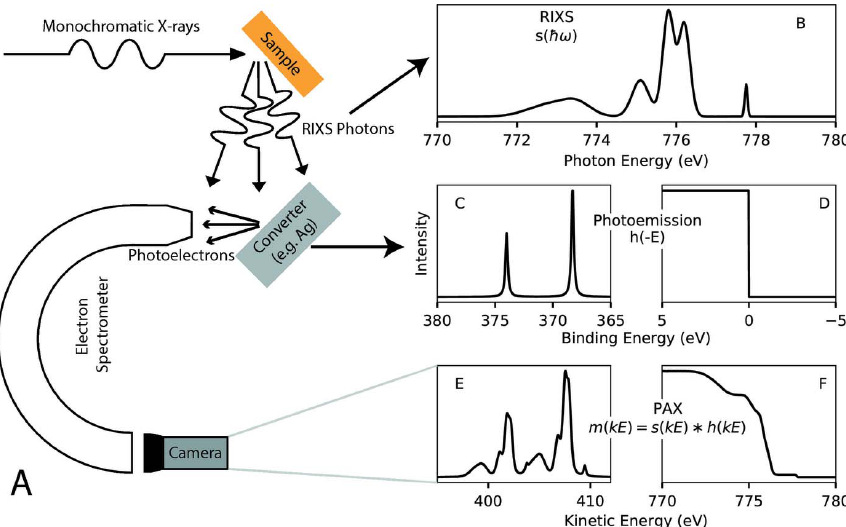
Figure 1 Concept of PAX for estimating RIXS spectra. (A) Experimental schematic. Monochromatic X-rays are incident on a sample which emits RIXS photons. These photons are directed onto a converter material resulting in photoemission. The energy distribution of these photoelectrons is detected with an electron spectrometer giving a PAX spectrum. We estimate the RIXS spectrum from the measured PAX spectrum and knowledge of the converter material photoemission spectrum. (B) Example model ground truth RIXS spectrum at the Co L 3 -edge (778 eV incident photon energy). (C) Ag 3 d -like model photoemission spectrum. (D) Sharp Fermi edge model photoemission spectrum, such as for Au. (E) Resultant PAX spectrum without noise for the X-ray spectrum in (B) and the photoemission spectrum in (C). (F) Resultant PAX spectrum without noise for the X-ray spectrum in (B) and the photoemission spectrum in